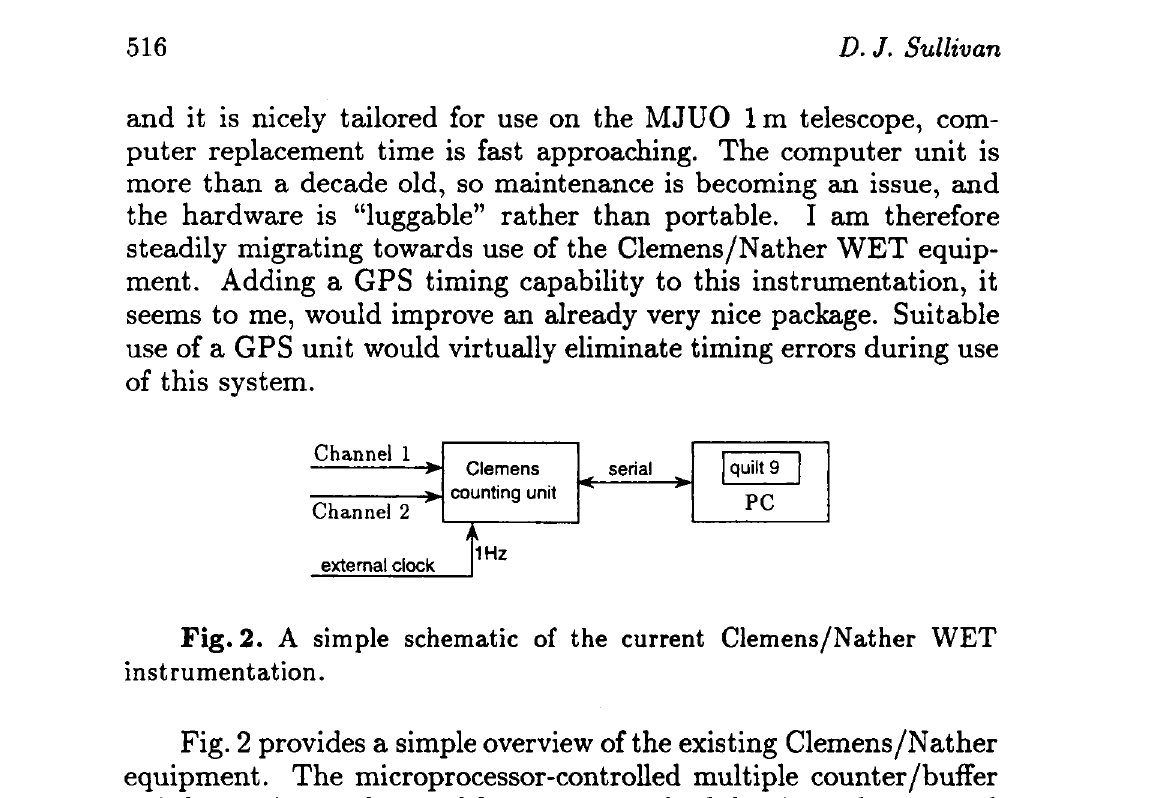
Fig. 2. A simple schematic of the current Clemens/Nather WET